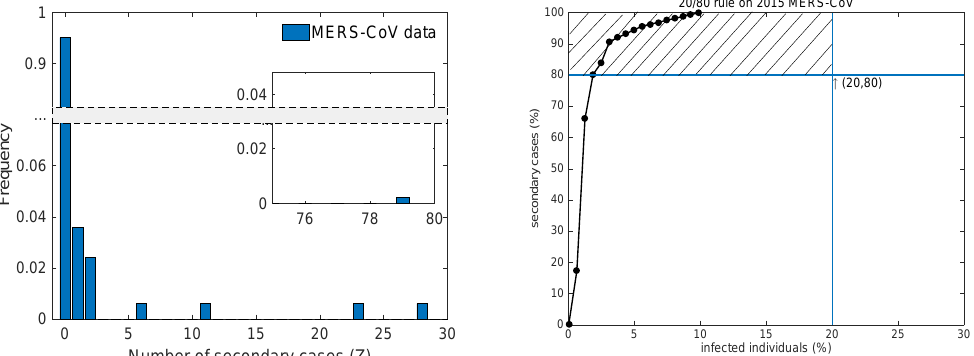
Figure 3. Distribution of the number of secondary cases ( left ) and the 20/80 rule of the 2015 MERS-CoV outbreak ( right ). In the right panel, an event that crosses the dashed area is called a superspreading event